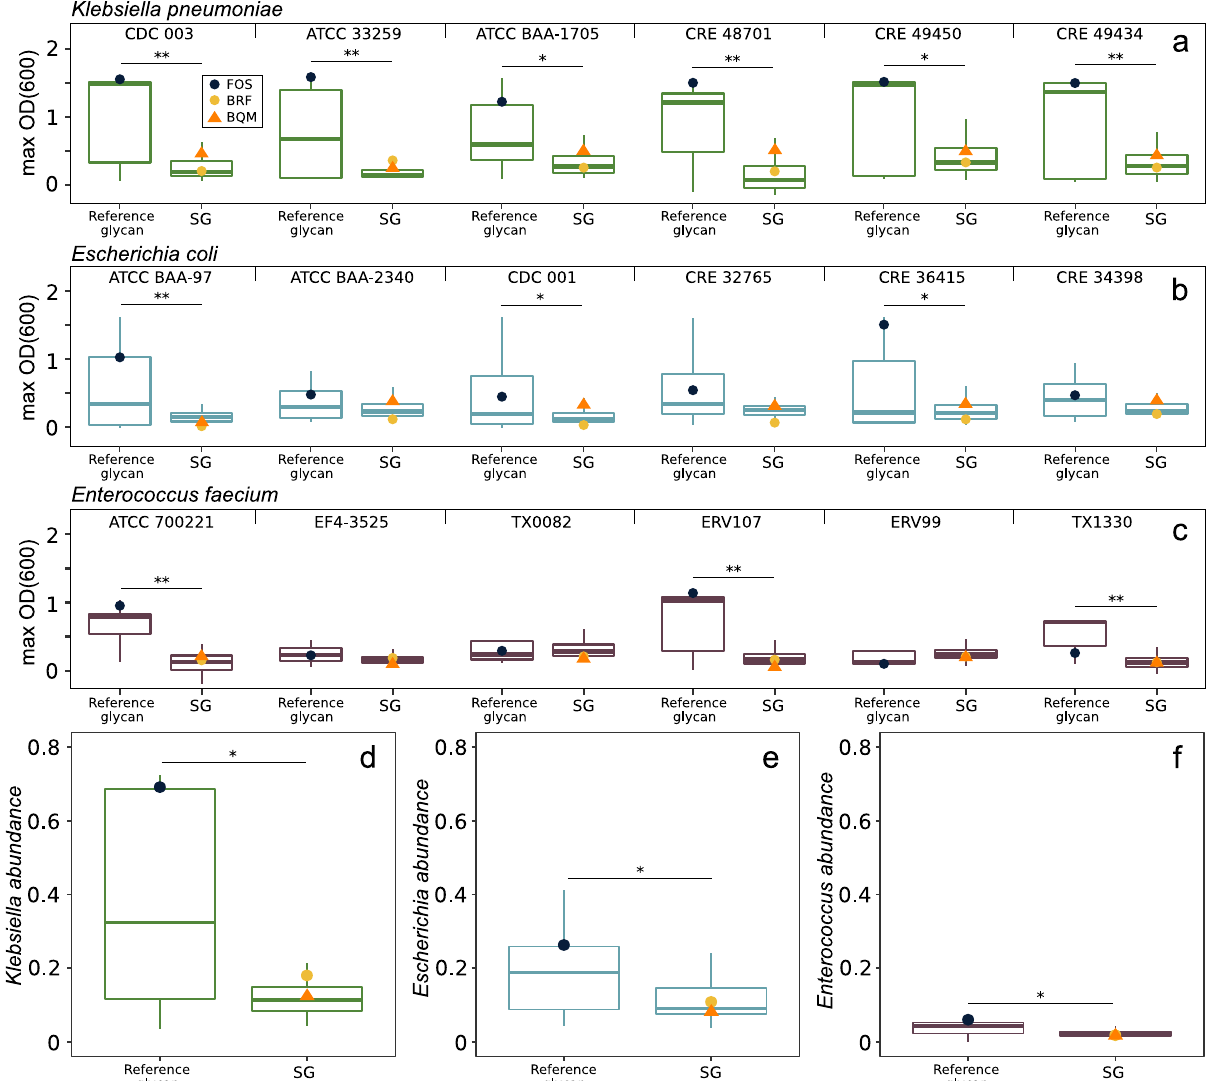
Fig. 3 Enteric pathogen growth in pure culture and relative abundances in fecal communities grown on glycans. Six strains of a Klebsiella pneumoniae , b Escherichia coli , or c Enterococcus faecium were cultured with 5 g l − 1 of a single SG ( n = 148) or reference glycan ( n = 32) in CM3 medium. Data is the mean maximum growth (OD 600 ) of triplicate cultures; strain names are shown above each plot. Fecal communities from a healthy donor were OD 600 - normalized to contain 8% of d K. pneumoniae CDC 003, e E. coli CDC 001, or f E. faecium ATCC 700221 and cultured in triplicate with 5 g l − 1 of an SG ( n = 45) or reference glycan ( n = 17) for 45 h in MM29 medium. The relative abundances of the pathogens were quanti fi ed by 16S rRNA gene sequencing. Data points show FOS (indigo circle), BRF (yellow circle), or BQM (orange triangle) cultures. Box plots show median and interquartile ranges. Asterisks show signi fi cance (* p < 0.05, ** p < 0.01) by two-sided Wilcoxon rank-sum test. Source data are provided as a Source Data fi le. SGs Synthetic